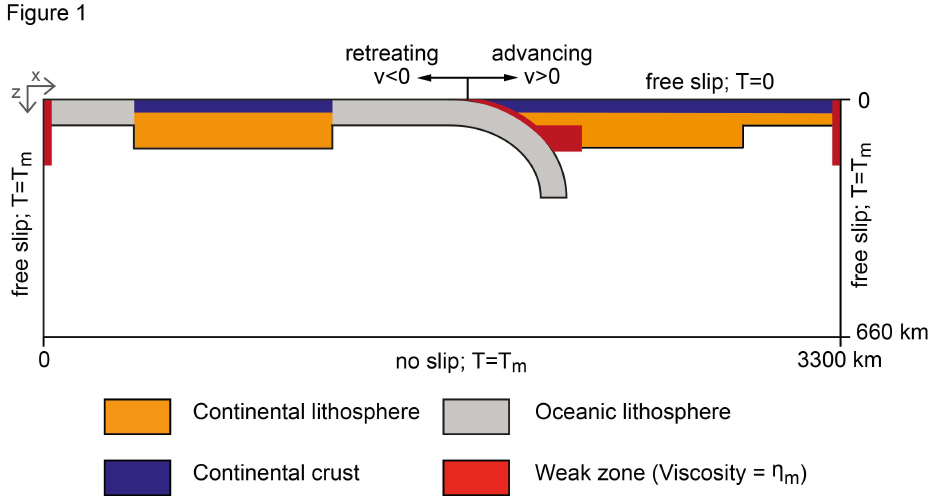
Fig. 1. Initial model setup with dimensions and mechanical and thermal boundary conditions. The model domain is 660km deep, and it has an aspect ratio of 1:5. The continental parts are modelled with a thick lithosphere (yellow) and a 40km buoyant crust (blue). Areas with an imposed low viscosity (i.e. the reference mantle viscosity) are outlined in